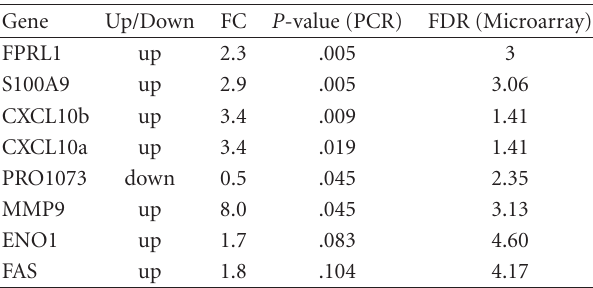
Table 4: PCR corroboration of di ff erentially expressed genes and Microarray-based